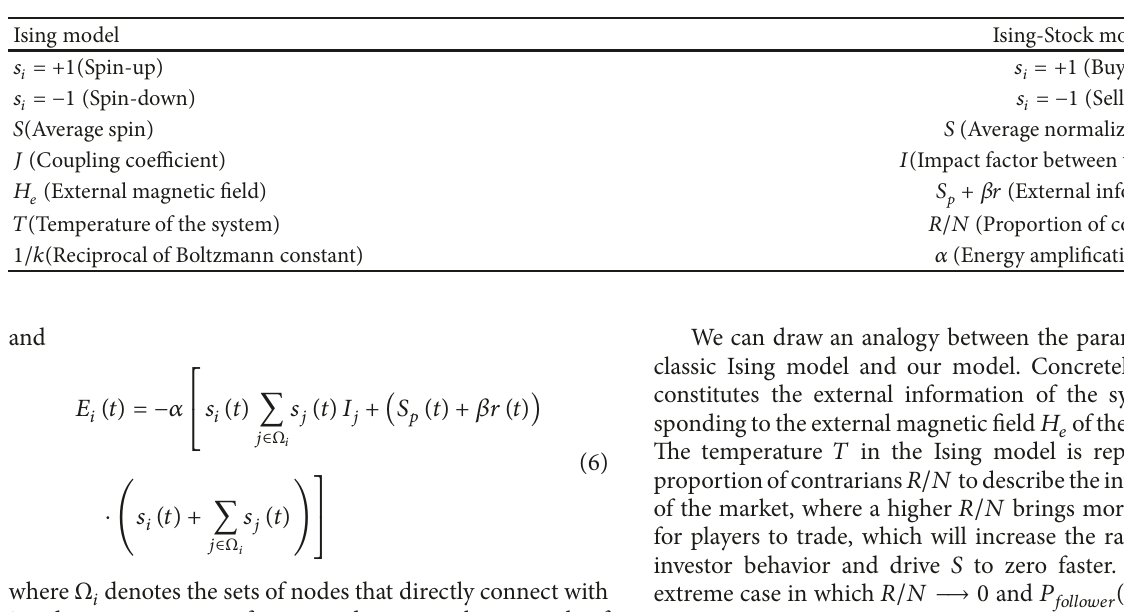
Figure 1: (a) Autocorrelation of log return rate of CSI300 Index from Jan 2004 to Jun 2017. The sequence is autocorrelated within about 20 lags empirically, which is why we set 𝑡/𝛿 ≤ 20 in (2). (b) Exception and threshold for trading action by contrarian timers in year 2016. The blue curve is the rate of return of the CSI300 Index in 2016. The red curve is the threshold to sell. The yellow curve is the threshold to buy. The black curve is the expectation of the returns. Table 1: Correspondence between Ising-Stock model and Ising